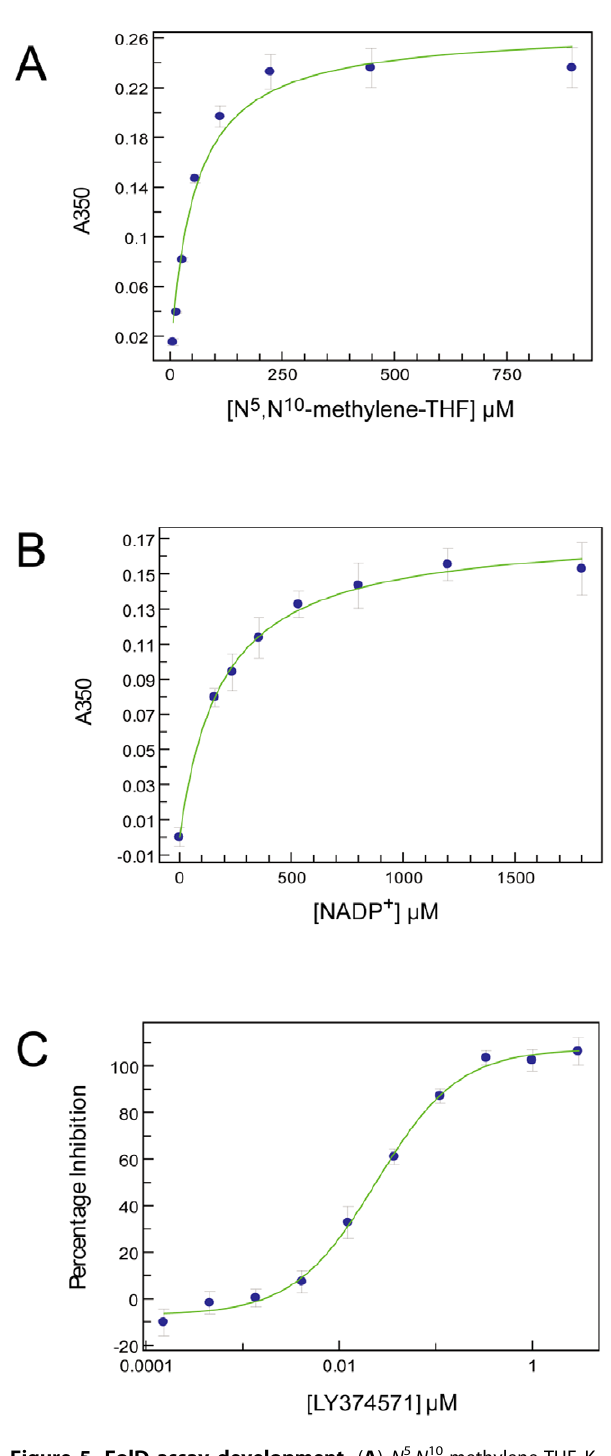
Figure 5. FolD assay development. ( A ) N 5 , N 10 -methylene-THF K m determination in the presence of 1 mM NADP + . ( B ) NADP + K M determination in the presence of 1 mM N 5 , N 10 -methylene-THF. All K M measurement data are presented as mean 6 SD (n=4) ( C ) Represen- tative IC 50 determination for LY374571. Data points are mean 6 SD (n=14). This representative example returns an IC 50 for LY374571 of 27 6 3 nM.